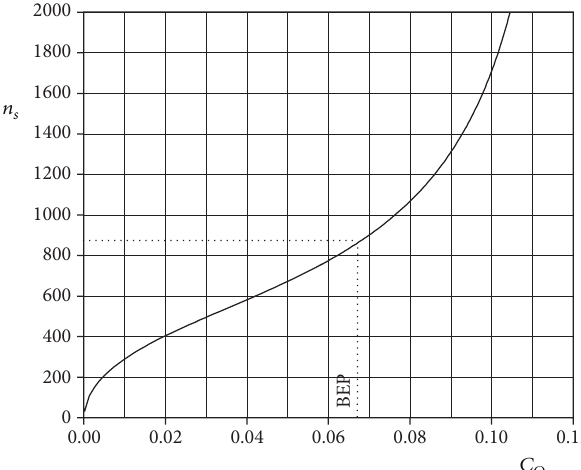
Figure 16: Pump specific speed values at different discharge coeffi- cient.